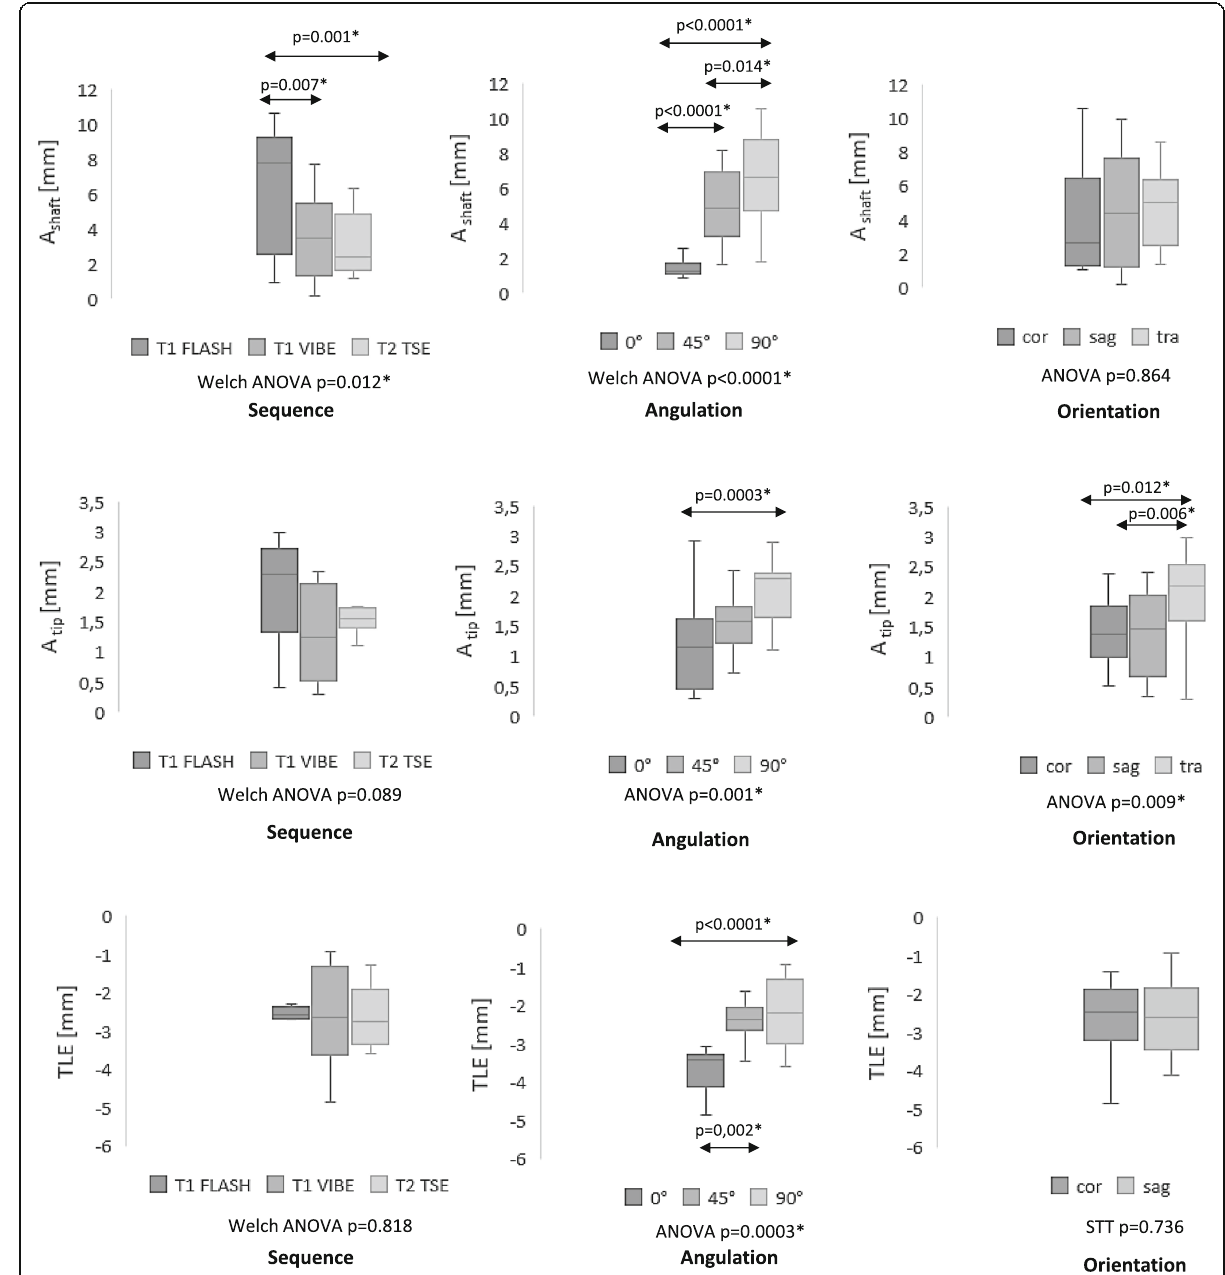
Fig. 2 Statistical analysis regarding the influence of the sequence type, applicator angulation to B 0 and slice orientation on the applicator artefact. Graphs display: A shaft (artefact diameter at the antenna shaft), A tip (artefact diameter at the antenna tip), and TLE (tip location error) of the microwave applicator in relation to sequence type, applicator angulation to B 0 and slice orientation. Depending on <2 or >2 parameters Student ’ s t test (STT) or ANOVA was performed. In case of overall statistical significance, the Student t test was performed according to the closed testing procedure. Whiskers indicate the minimum and maximum extreme values; the box indicates the upper and lower quartile. The line in the box indicates the median